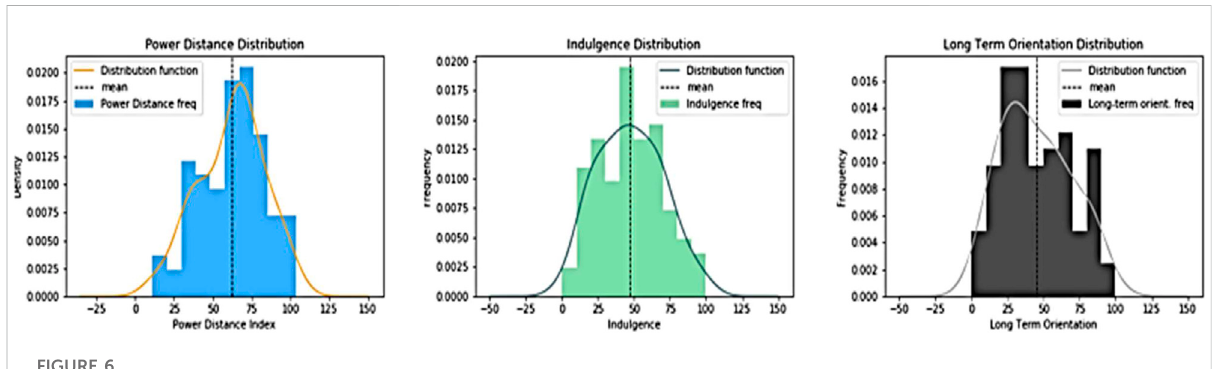
FIGURE 6 Determination of decision rule for one country as an example.